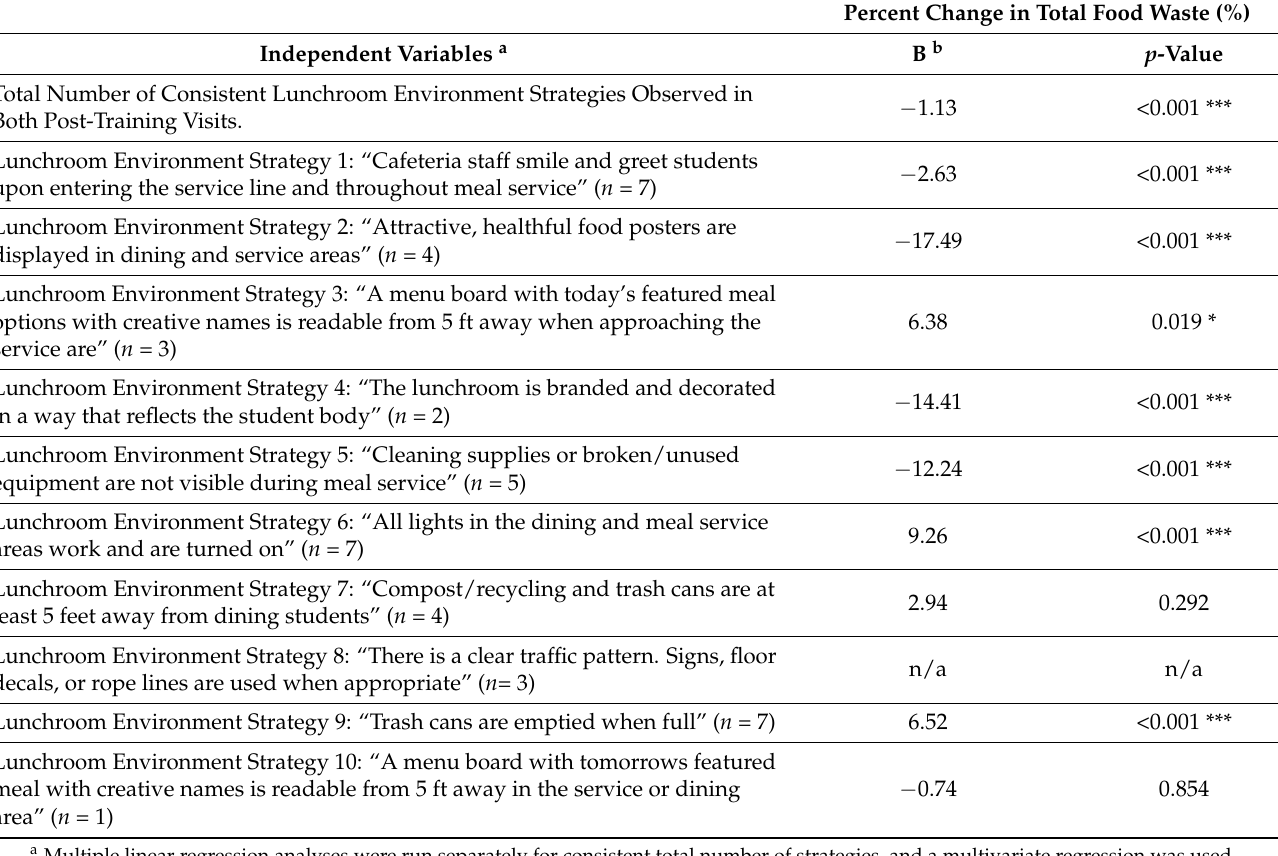
Table 3. Coefficient Estimates for Multiple Linear and Multivariate Regression Analyses Examining Associations Between the Total Number and Type of Consistent Lunchroom Environment Strategies Implemented with Percent Change in Total Food Waste ( n = 15). Percent Change in Total Food Waste (%) Independent Variables a B b p